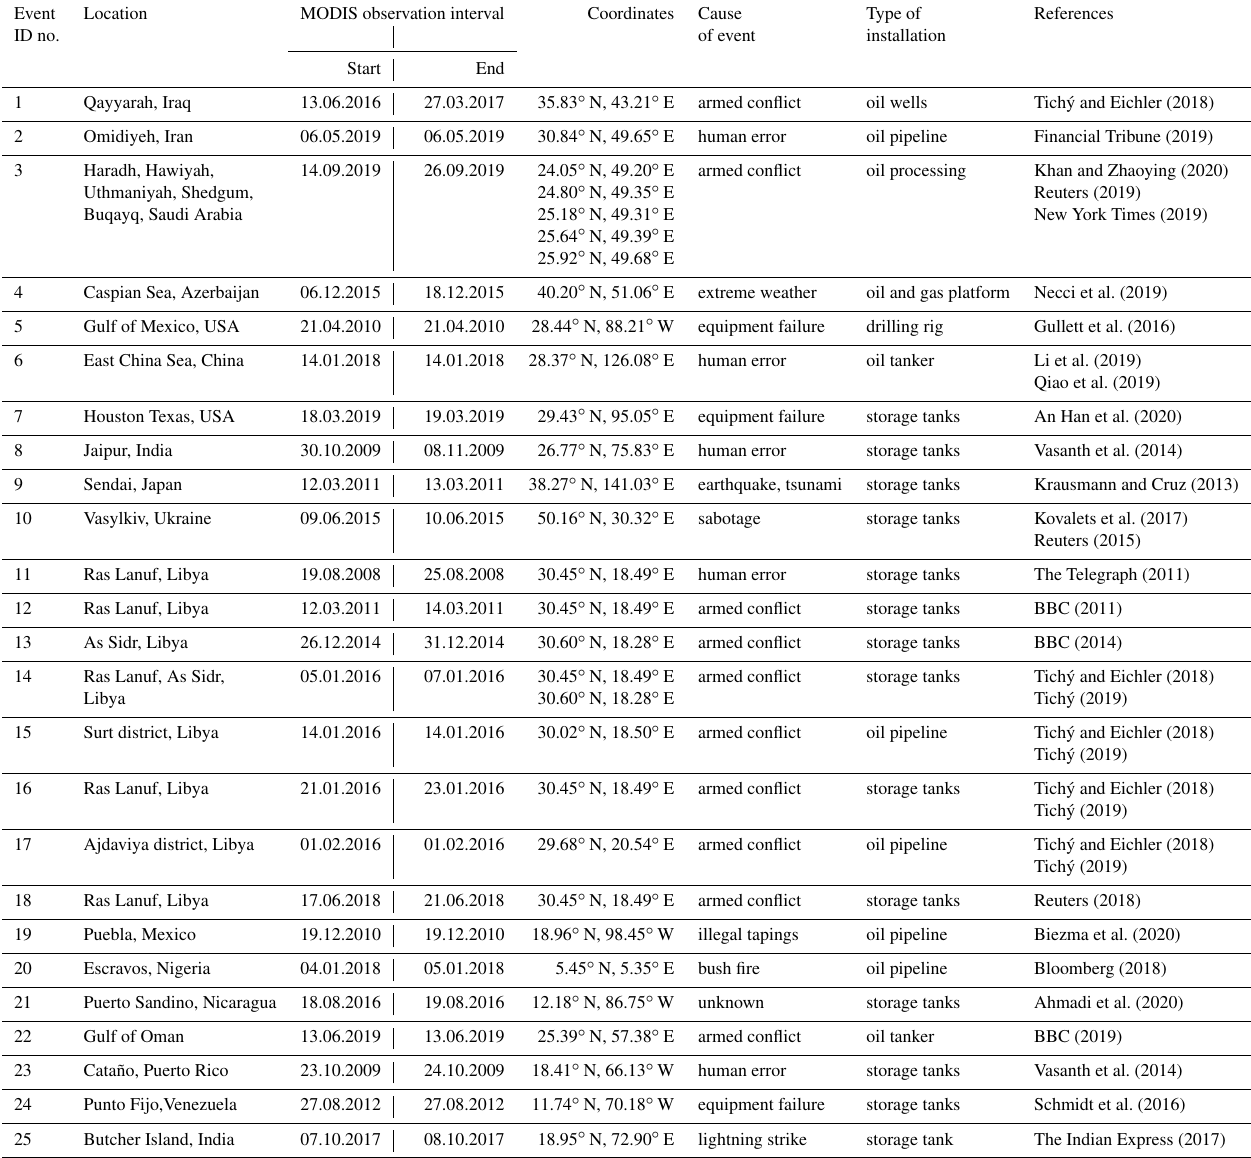
Table 1. Major industrial events leading to observable smoke plumes seen in MODIS RGB